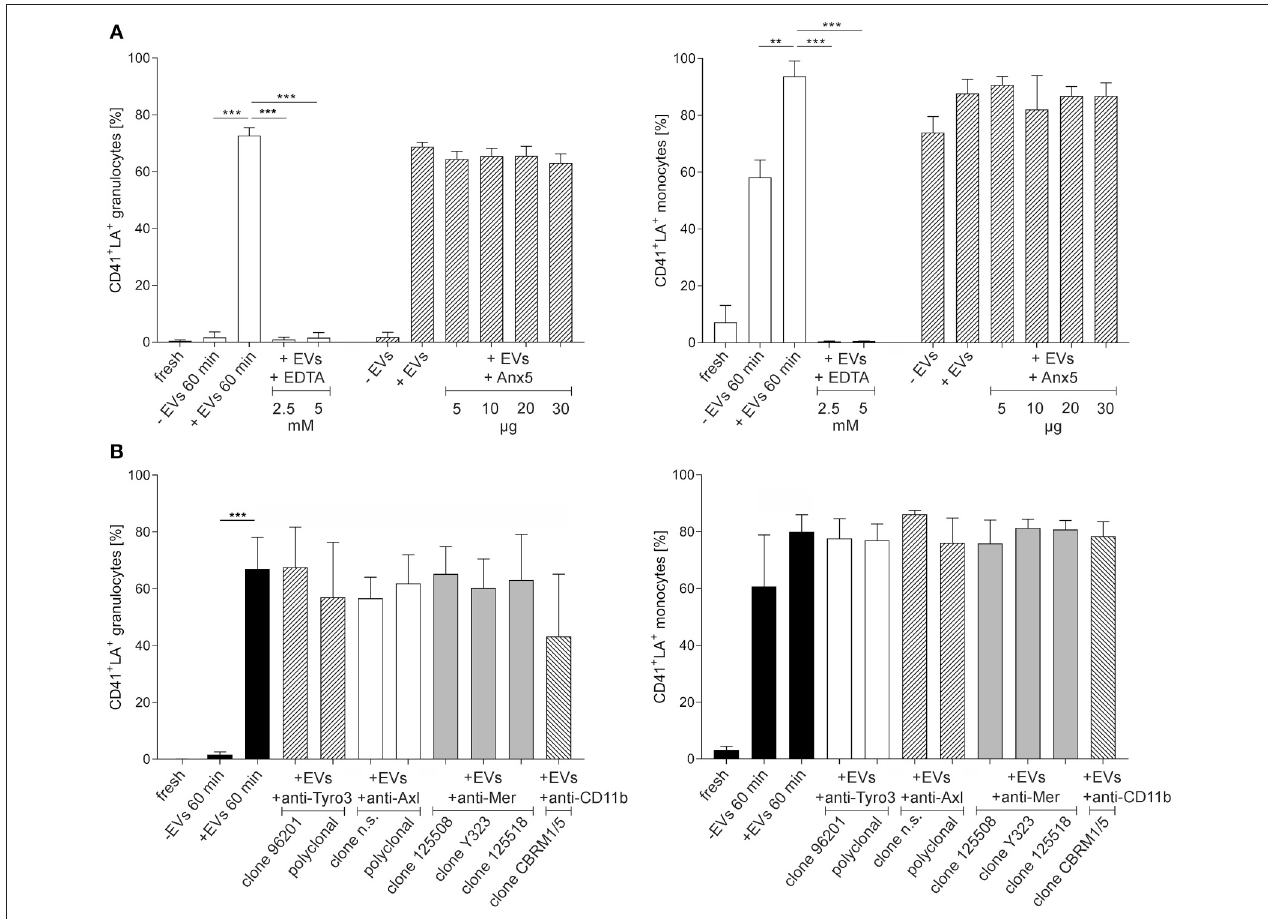
FIGURE 5 | Effect of Ca ++ , phosphatidylserine, TAM receptors, and CD11b on the binding of platelet-derived extracellular vesicles to granulocytes and monocytes. Isolated granulocytes and monocytes were incubated with platelet-derived EVs as described in the Methods section, or left untreated. Granulocytes or monocytes associated with platelet-derived EVs were identified as CD41 + lactadherin + events in flow cytometry. Characterization was performed in freshly isolated immune cells (fresh) and after co-incubation of immune cells with platelet-derived EVs ( + EVs 60min). Immune cells incubated without EVs served as control (–EVs 60min). The different levels of granulocytes or monocytes associated with EVs in the control at 60min are due to endogenous EV release from residual platelets. As specified in the Results section, platelets were hardly detectable in isolated granulocytes, while isolated monocytes contained significant amounts of residual platelets, resulting in EV release during incubation. (A) To assess the dependence of the interaction on Ca ++ , co-incubation of EVs and immune cells was performed both in the presence and absence of EDTA (2.5 and 5mM final concentration). To mask PS, platelet-derived EVs were pre-incubated with Anx5, and the efficiency of PS blocking was confirmed by the abrogation of thrombin generation in the presence of Anx5 as shown in Figure S5 . (B) The influence of TAM receptor or CD11b blocking was assessed by pre-treatment of granulocytes and monocytes with anti-Tyro3, anti-Axl, anti-Mer, or anti-CD11b antibodies as specified in Table S1 , followed by co-incubation of the pre-treated immune cells with platelet-derived EVs, revealing that neither TAM receptor blockade nor masking of activated CD11b had an impact on the binding of platelet-derived EVs to granulocytes and monocytes ( n = 3). Data are given as mean ± standard deviation. ** p < 0.01; *** p < 0.001. LA, lactadherin; n.s., not